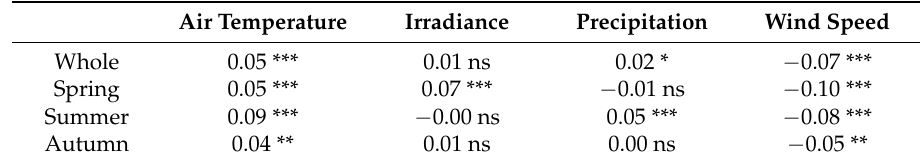
Table A2. Monotonic long-term trends using Kendall correlations in climate averaged for all lakes.